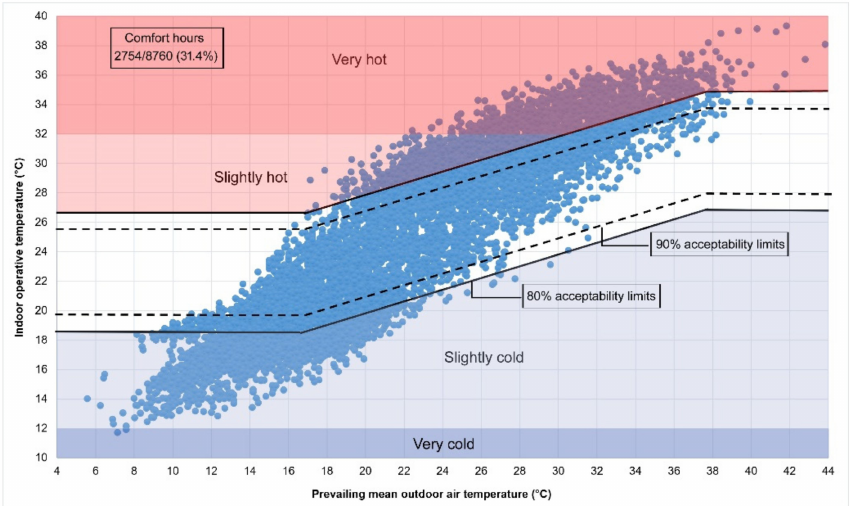
Figure 4. Comfort result and analysis of the base case of the reference building based on the ASHRAE- 55-2020 adaptive comfort model at 90% acceptability